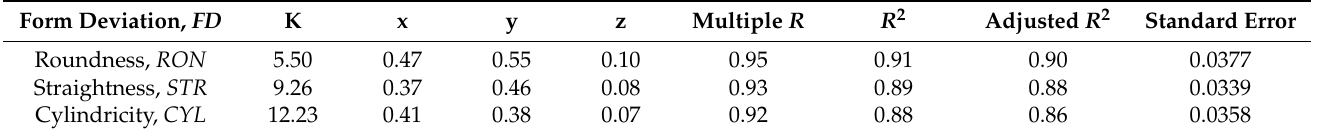
Table 5. Model coefficients and regression statistics.